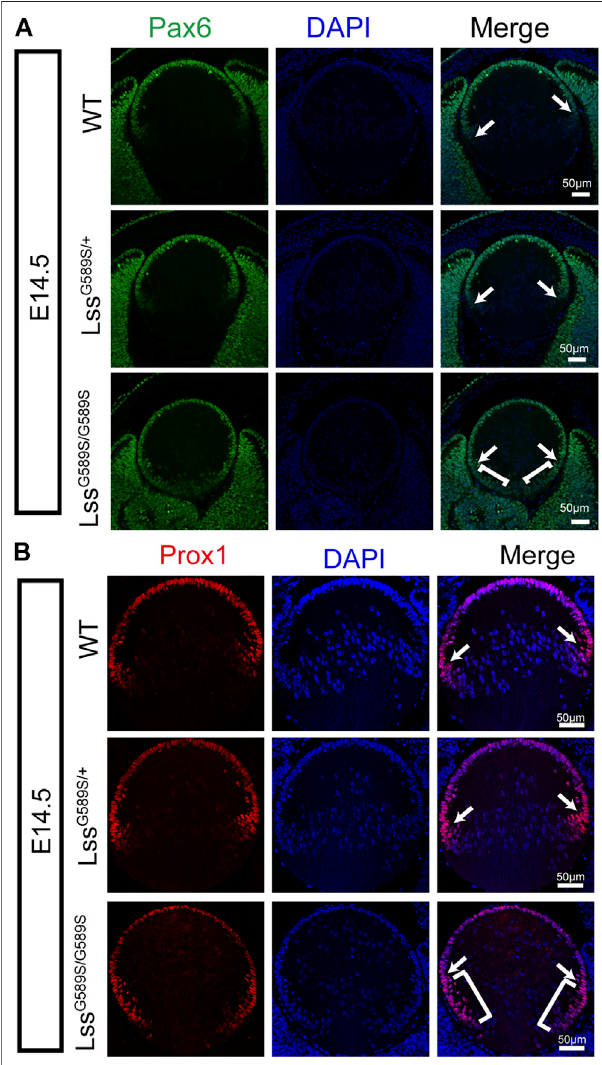
( Figures 4C – E , black arrow). Our fi ndings indicated that visible opacity was formed in embryonic lens of Lss G589S/G589S homozygous mice at E17.5.